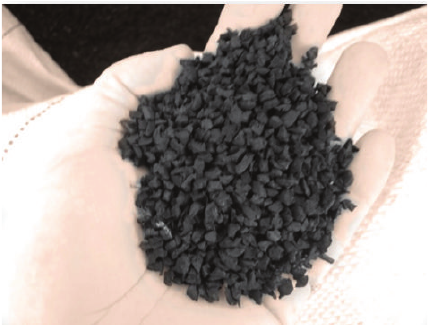
Figure 1: Rubber